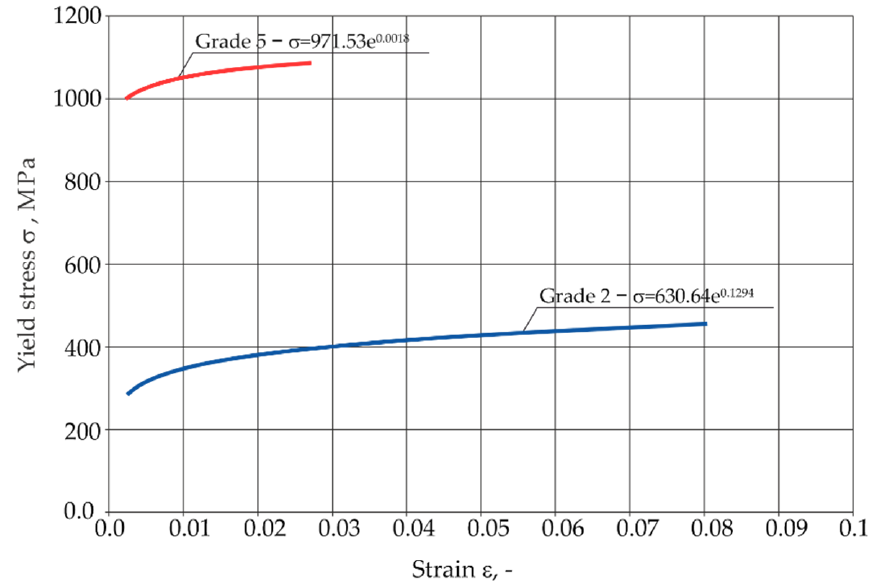
Figure 9. Hardening curves for the analyzed titanium samples.